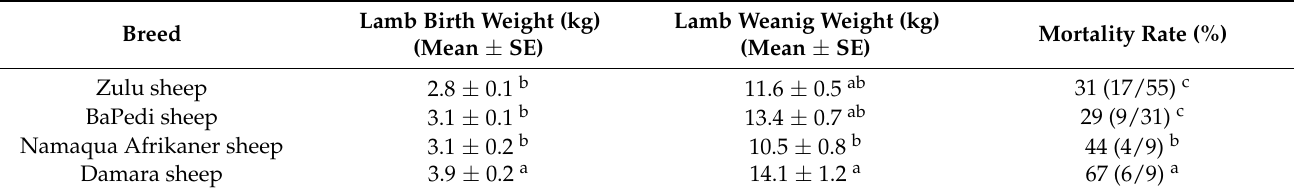
Table 8. The birth, weaning weight and mortality rate of South African indigenous sheep breeds [43].